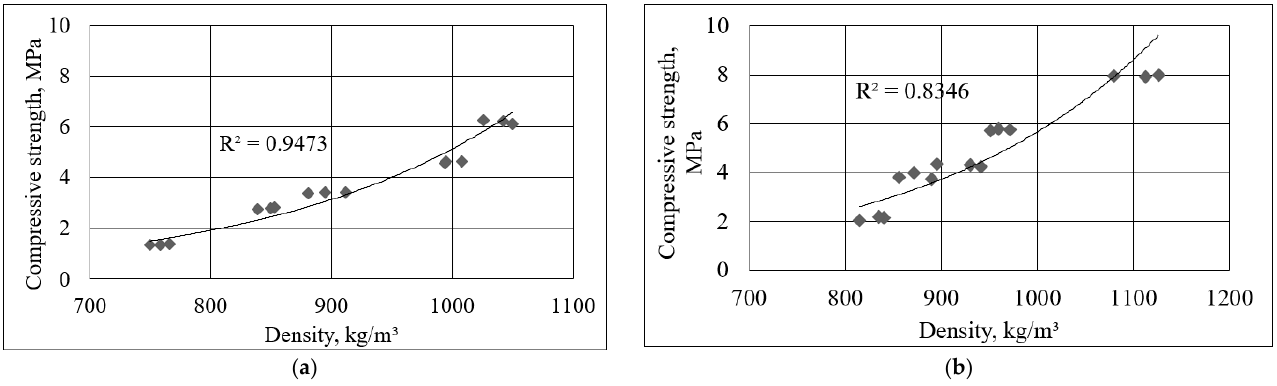
Figure 9. Relationship between density and compressive strength after 7 days ( a ) and 28 days ( b ) of hardening at different additions of phosphogypsum.